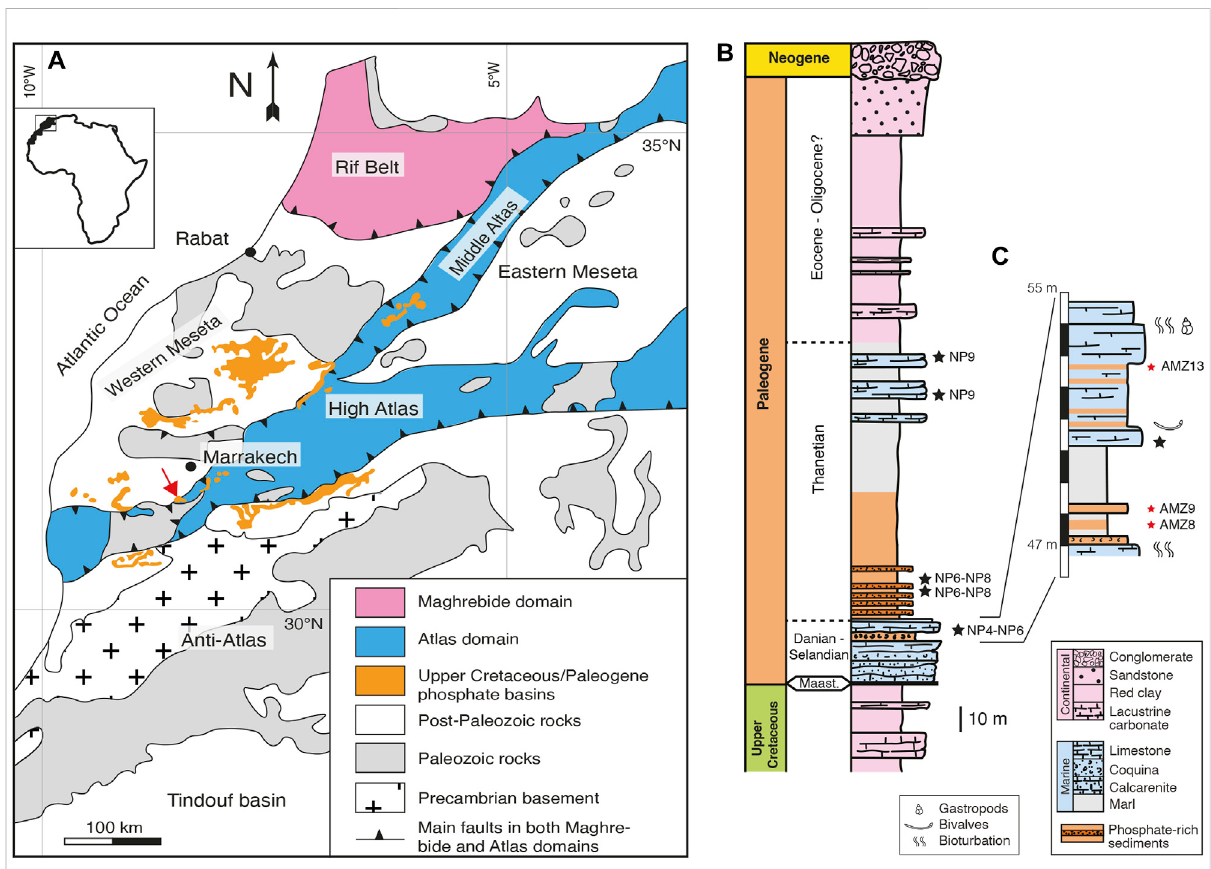
FIGURE 1 Geological map and lithostratigraphic column. (A) Simpli fi ed geological map and structural units of Morocco. The red arrow indicates the studiedAmizmizsection,31 ° 12 ′ 09 ″ N,08 ° 14 ′ 08 ″ W.Geologicalmapadoptedfrom(Hollardetal.,1985)andthe fi gureismodi fi edfromAubineauetal. (2022). (B) Stratigraphic framework of the Amizmiz phosphate-bearing series. The fi gure is modi fi ed from El Bamiki et al. (2020). (C) Detailed lithostratigraphic column of the maximum fl ooding zone showing the sampled P-rich horizons. This interval results from a sedimentary condensation. Key nannofossil Zones are in black in b and c panels. NP: Paleogene